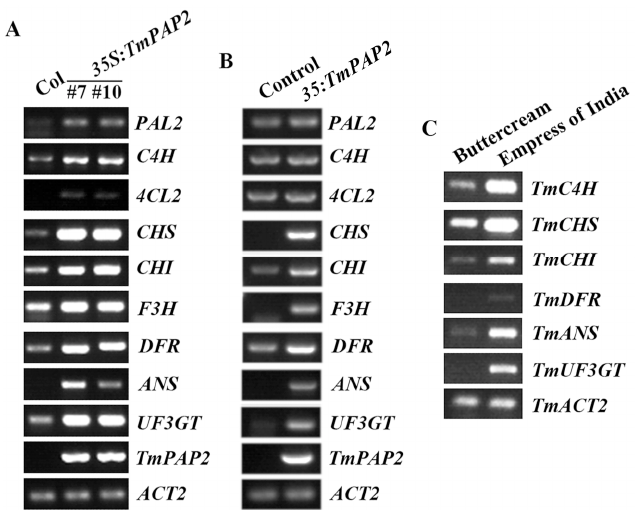
Figure 5. Expression of biosynthesis genes in the general phenylpropanoid pathway and anthocyanin biosynthesis pathway. ( A ) Expression of the biosynthesis genes in the Col wild-type and the TmPAP2 transgenic Arabidopsis plants. RNA was isolated from 10-day-old seedlings and RT-PCR was used to examine the expression of the genes. The expression of ACT2 was used as a control. ( B ) Expression of the biosynthesis genes in TmPAP2 transfected protoplast. Protoplasts were isolated from the Col wild-type Arabidopsis , then the plasmid DNA of TmPAP2 or CAT control was transfected into the protoplasts; the transfected protoplasts were incubated in darkness for 20–22 h, and then the RNA was isolated and used for RT-PCR, to examine the expression of the genes. The expression of ACT2 was used as a control. ( C ) Expression of the biosynthesis genes in the “Buttercream” and the “Empress of India” nasturtiums. RNA was isolated from 7-day-old soil-grown seedlings, and RT-PCR was used to examine the expression of the genes. The expression of TmACT2 was used as a control.